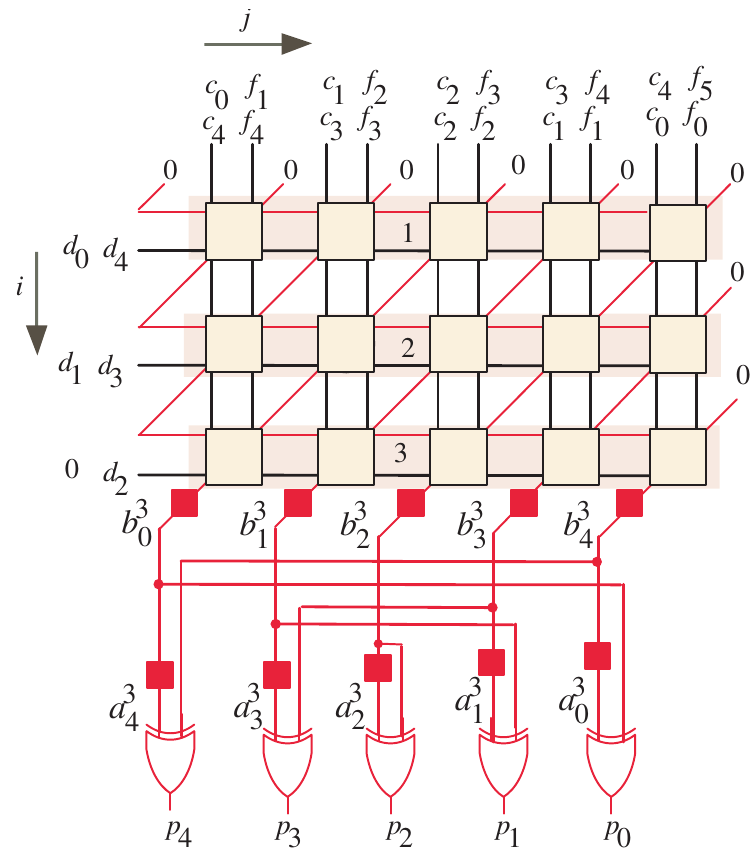
Figure 2. Node timing for m =